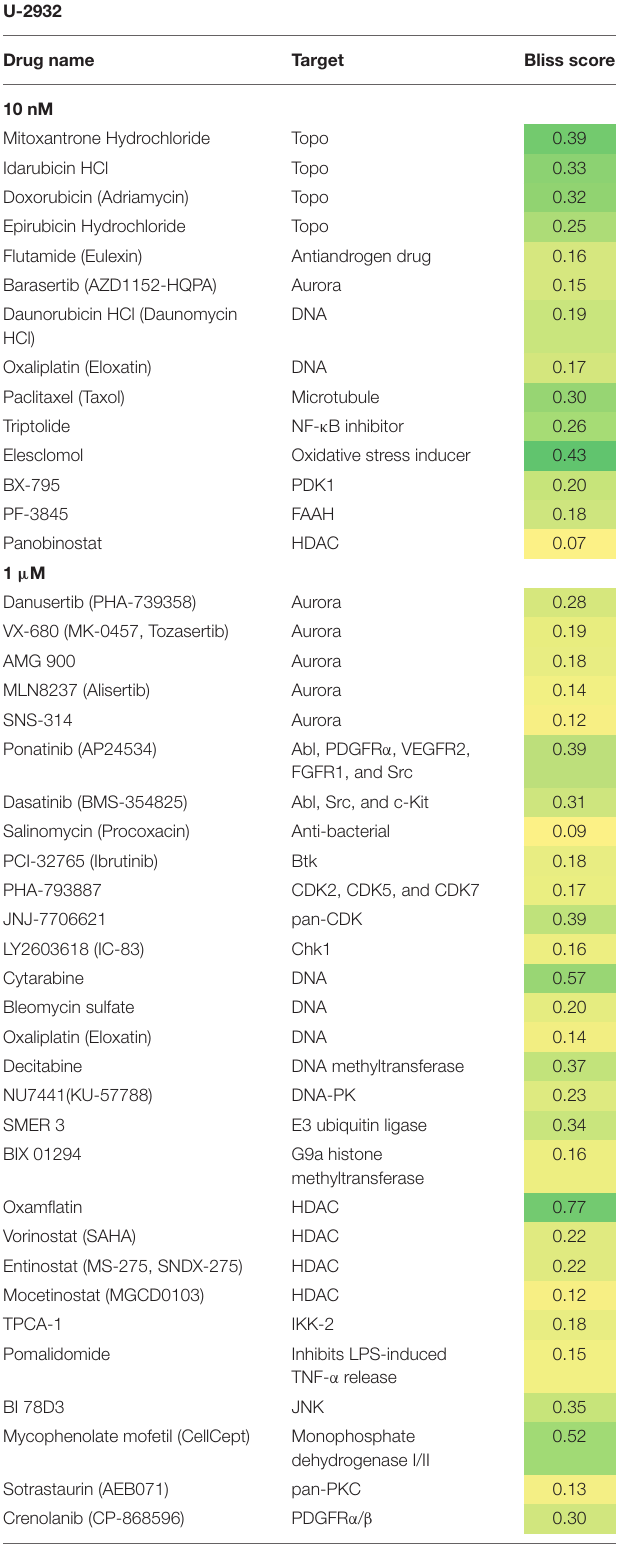
TABLE 2 | Hit candidate list from screen in U-2932